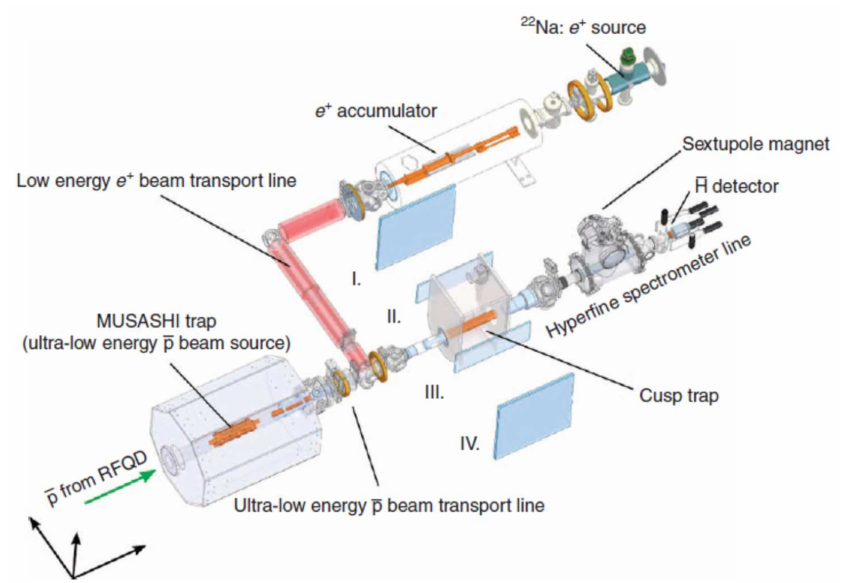
Figure 3. Schematics of the ASACUSA experiment, featuring the typical structure of an experiment at the Antiproton Decelerator. Antiprotons are collected from the AD line (left-hand side) and caught in an antiproton trap (MUSASHI). At the same time, positrons are produced by the radioactive source (top right) and stored in an e + accumulator. The two species are then transported and mixed in the trap (Cusp trap), whose confining potential is discussed in the text. The anti-Hydrogen formed in this way is used for further experimentation at the line on the lower